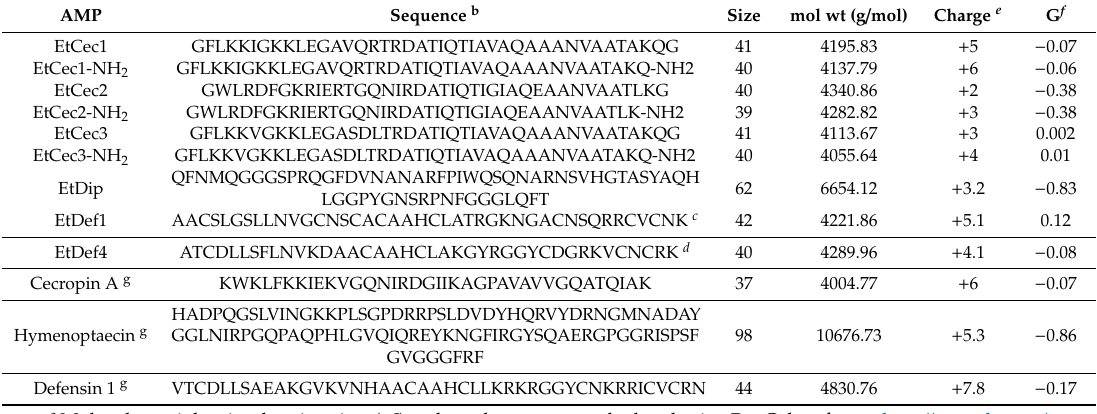
Table 1. Properties of nine synthetic Eristalis tenax antimicrobial peptides (AMPs) a